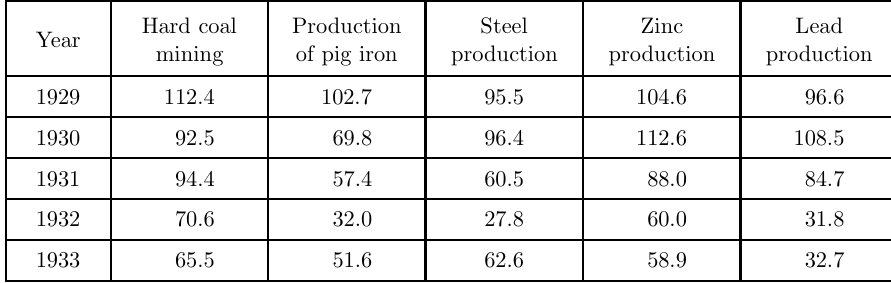
Production volume of selected products of the Upper Silesian industry in 1929–1933 (1928 = 100) Hard coal Production Steel Zinc Lead Year mining of pig iron production production